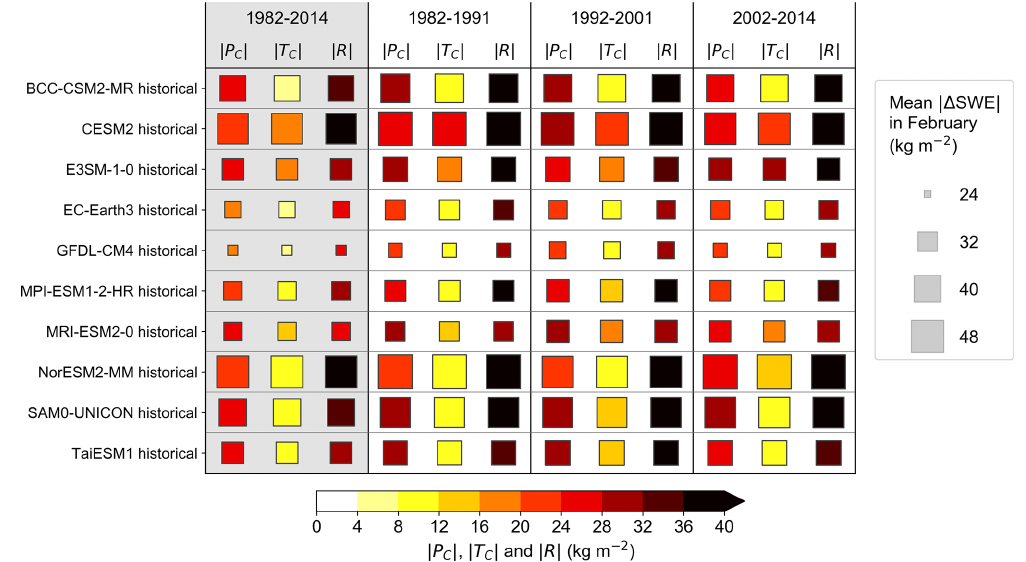
Figure 6. The areal means of the absolute values of (cid:49) SWE, P C , T C , and residual R calculated for the entire study period 1982–2014 (left column, shaded with grey) and for three shorter time periods (1982–1991, 1992–2001, and 2002–2014) for each model in winter. The size of the square indicates the absolute value of (cid:49) SWE of that time period and model, and the color of the square indicates the absolute value of P C , T C , and R